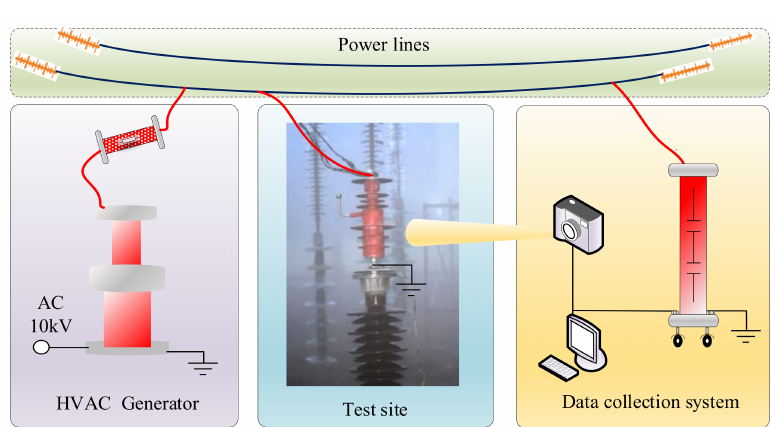
Figure 2. Natural Icing Test Base.